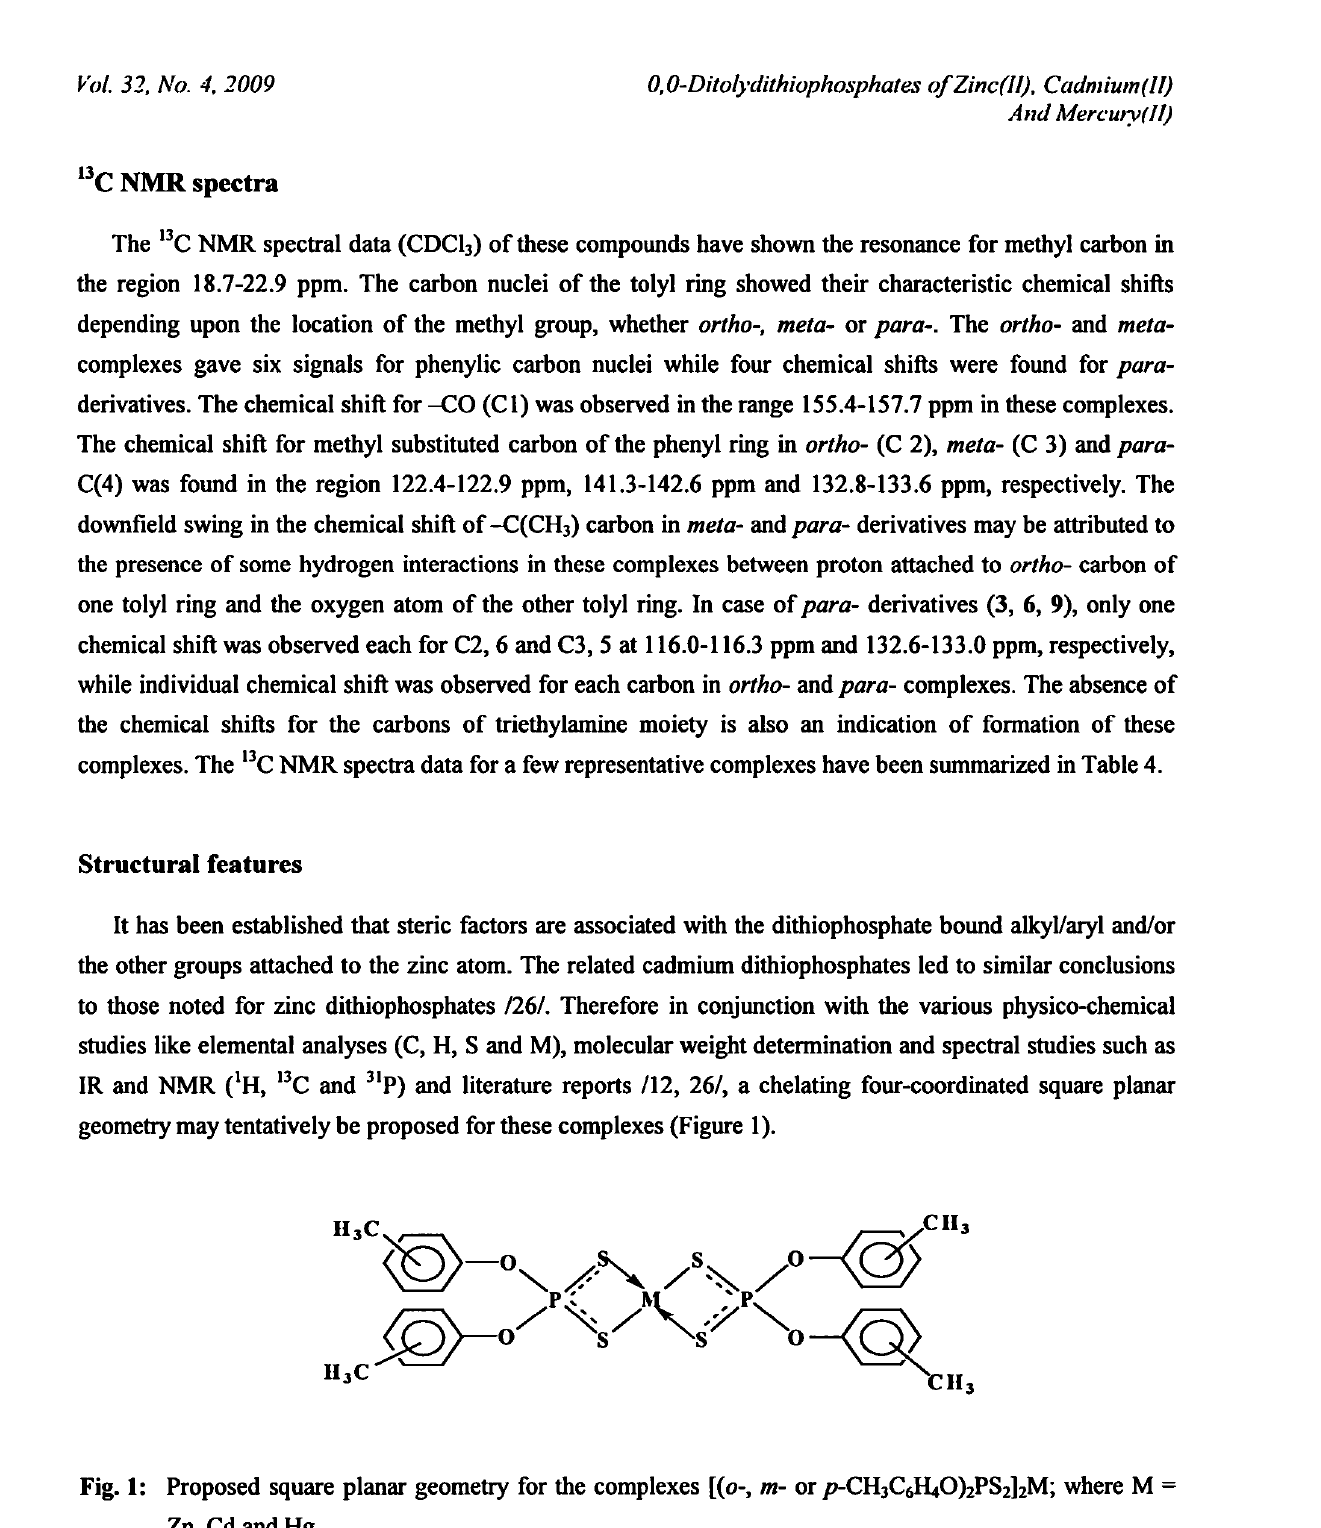
C H4O) PS2]2M; where M 3 6 2